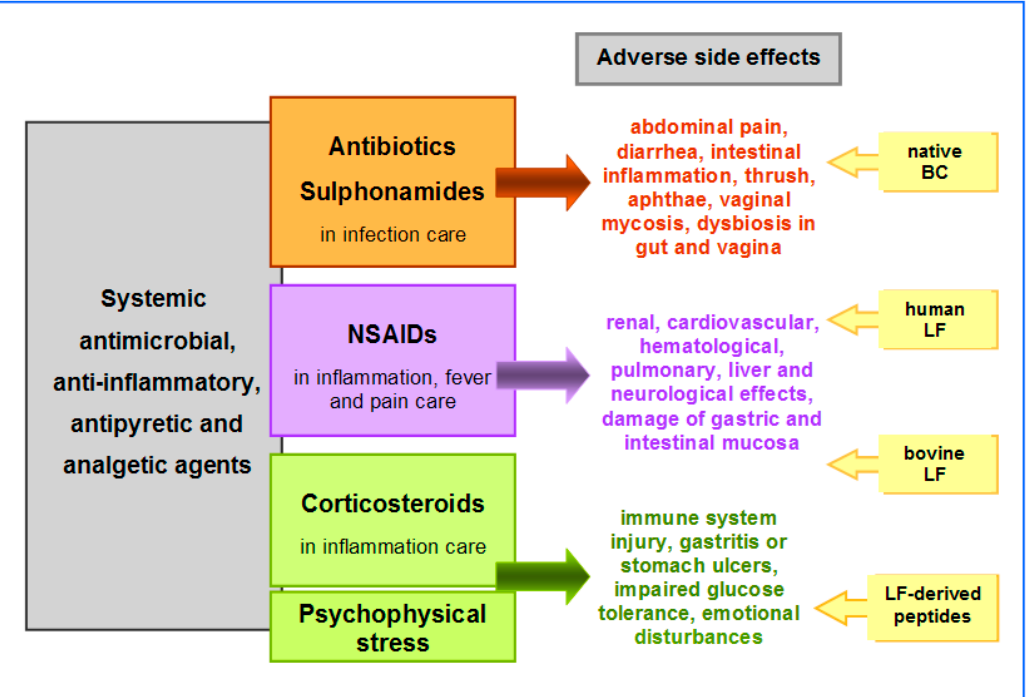
Figure 1. Systemic antimicrobial agents—antibiotics and sulfonamides and anti-inflammatory, an- tipyretic and analgetic agents—NSAIDs and synthetic corticosteroids in therapy of infections, in- flammation, fever and pain. BC and its bioactive constituents (LF and other proteins) may be used as supportive care in preventing and treating adverse side effects of these therapies, as well as for the alleviation of endogenous, steroid-induced physiological effects of psychophysical stress.